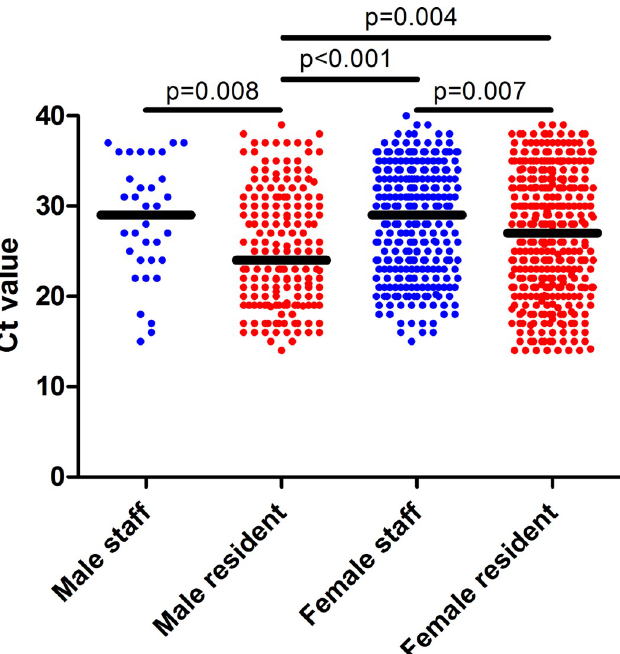
Fig 3. The cycle threshold values (Ct-values) of symptomatic male staff (n = 34) and male residents (n = 189), as well as female staff (n = 287) and female residents (n = 422), the Netherlands, 27 February –1 June 2020. Each dot represents an individual case. The black line shows the median Ct-value for the respective